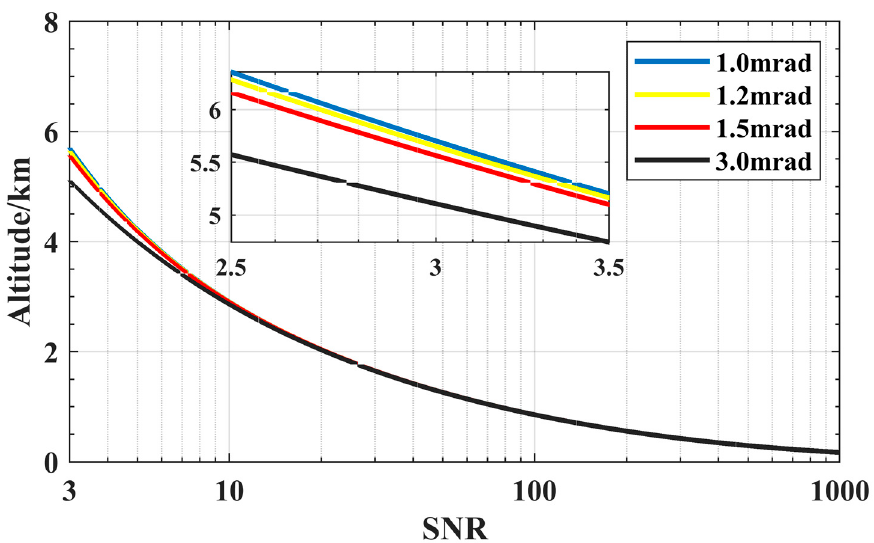
Figure 4. SNR curves of lidar corresponding to different FOV: 1.0 mrad (blue), 1.2 mrad (yellow), 1.5 mrad (red), 3.0 mrad (black).